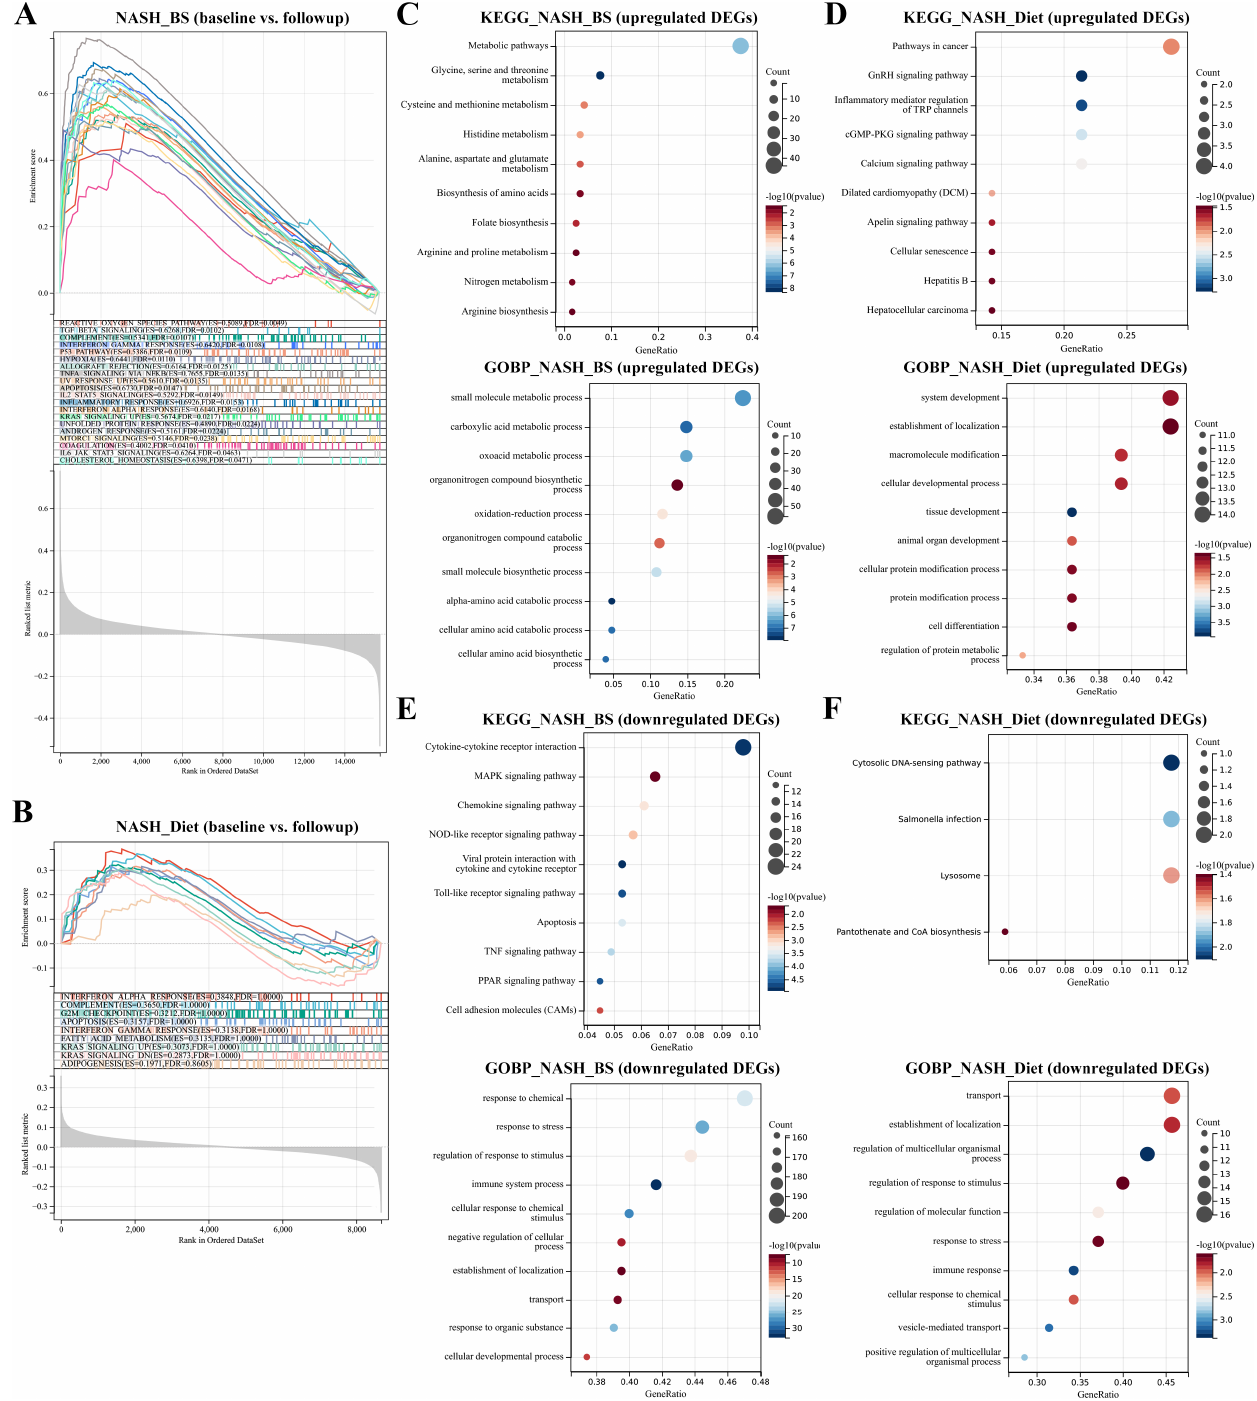
Figure 2. Function enrichment. Hallmark enrichment analyses were conducted in the NASH_BS and NASH_Diet subgroups. ( A ) 20 significant hallmark terms were shown with enrichment scores (ES) in NASH_BS subgroup (FDR adjusted p < 0.05). ( B ) 9 top ‐ ranked (but not significant) hallmark terms were shown in the NASH_Diet subgroup (FDR adjusted p > 0.05). KEGG and GO enrichment analyses were conducted in NASH_BS and NASH_Diet subgroups. Top significant KEGG and GO terms from upregulated and downregulated gene clusters were respectively displayed ( C – F ) ( p < 0.05).